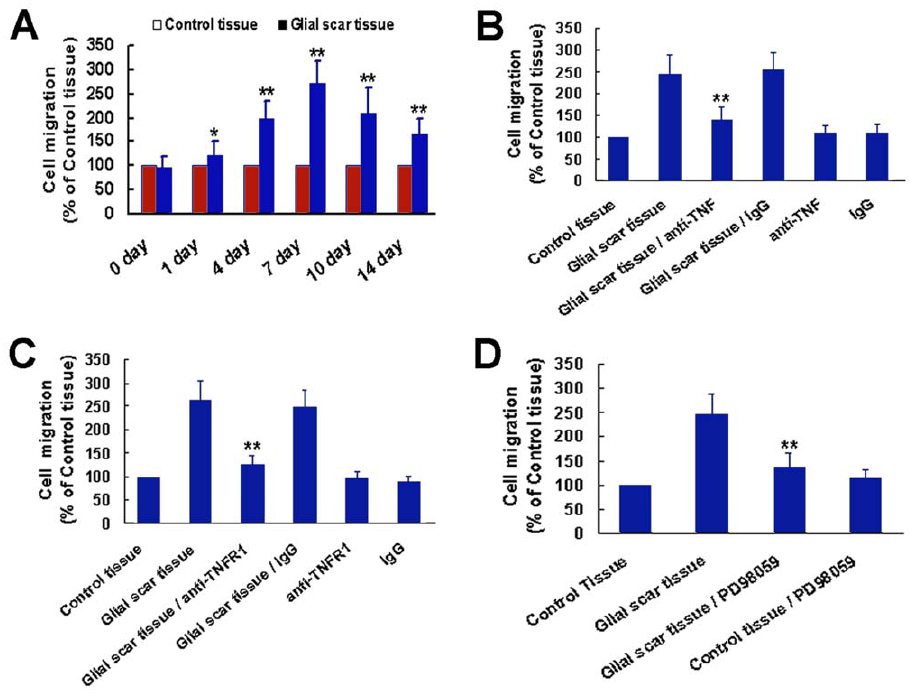
Figure 7. The effect of glial scar on OECs migration is mediated by secreted TNF- a . (A) Glial scar promotes OECs migration in a manner of time-dependence. * P , 0.05 or ** P , 0.01 versus control tissue. (B, C) The effect of glial scar on OECs migration is mediated by TNF- a and TNFR1. OECs were pretreated with TNF- a antibody (5 m g/mL), TNFR1 antibody (2 m g/mL) or goat IgG for 2 hours, and then incubated with glial scar tissue in a Boyden chamber. Cells without pretreatment but with glial scar tissue stimulation were defined as glial scar tissue group. Cells without pretreatment but with control tissue stimulation were defined as control tissue group. ** P , 0.01 versus glial scar tissue. (D) ERK activation is involved in glial scar- induced OECs migration. PD98059 treatment significantly attenuated the effect of glial scar tissue on OECs migration. ** P , 0.01 versus glial scar tissue group.